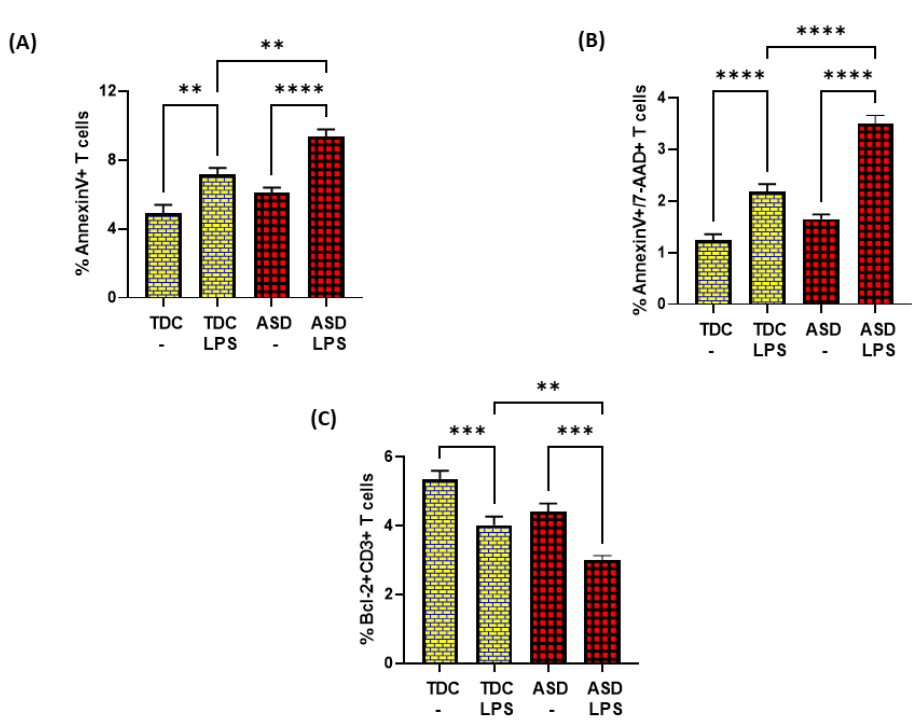
Figure 5. Bcl2 expression and apoptosis in the T cells of the ASD and TDC groups in response to LPS. ( A ) Annexin V+ T cells, ( B ) Annexin V+/7-AAD+ T cells, and ( C ) Bcl-2+ T cells. PBMCs were segregated from whole followed and treated with LPS, followed by flow cytometry. Values are shown as the mean ± SEM, n = 15/group. ** p < 0.01; *** p < 0.001; **** p < 0.0001.